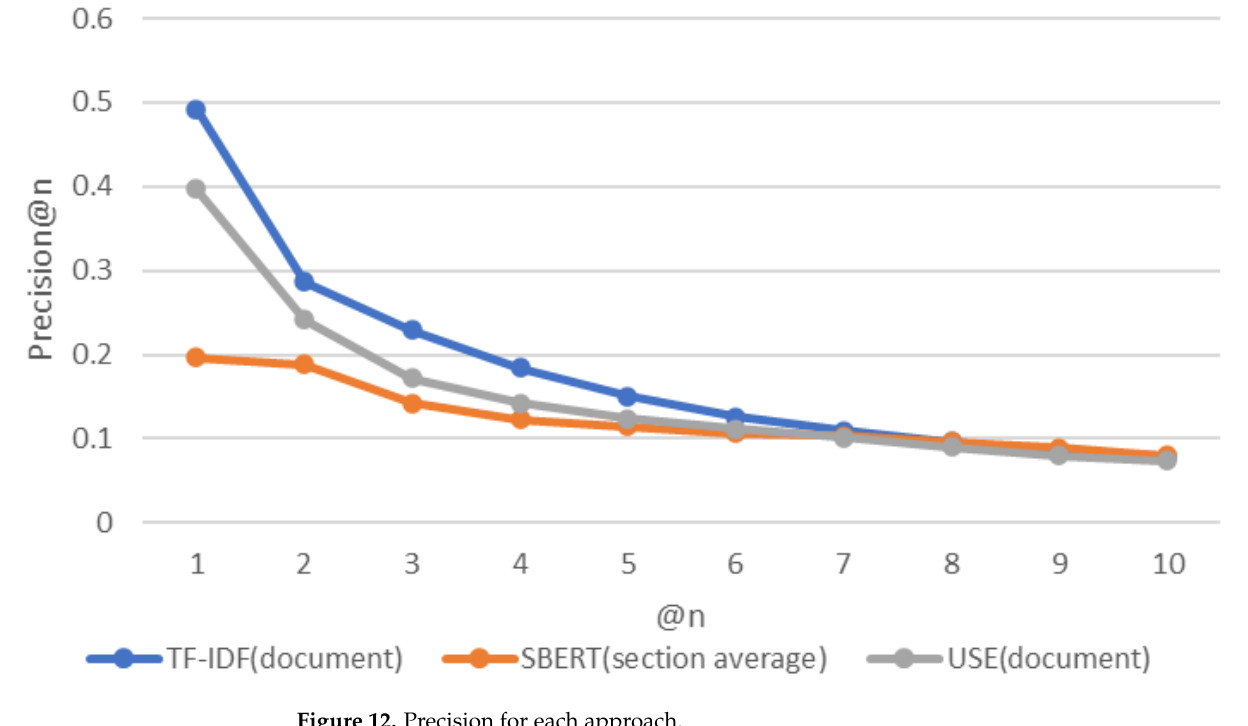
Figure 12. Precision for each approach.